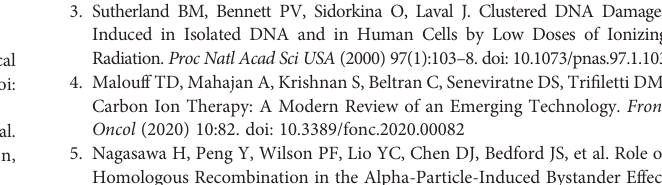
Supplementary Figure 1 | Sham-irradiated plating ef fi ciencies (PE) ± SEM for G0/G1-phase normal NFF28 primary fi broblasts (A) and asynchronously growing A549 lung carcinoma (B) , U2OS osteosarcoma (C) , and U87MG malignant glioma cells (D) pretreated for 18 h with 0.1% DMSO (vehicle control) or 1 – 20 µM concentrations of SAHA, M344, and PTACH. Asterisks mark signi fi cant differences at p -values of ≤ 0.05 (*), ≤ 0.01 (**), ≤ 0.001 (***), and ≤ 10 − 4 (****). Supplementary Figure 2 | Clonogenic survival of G0/G1-phase normal NFF28 primary fi broblasts (A) and asynchronously growing A549 lung carcinoma (B) , U2OS osteosarcoma (C) , and U87MG malignant glioma cells (D) pretreated for 18 h with 1 – 20 µM concentrations of M344 and exposed to 0.5 – 6 Gy cesium-137 g -rays. Data reported as mean ± SD; where error bars are not visible, they are smaller than the data point. Asterisks mark signi fi cant differences at p -values of ≤ 0.05 (*). Supplementary Figure 3 | Clonogenic survival of G0/G1-phase normal NFF28 primary fi broblasts (A) and asynchronously growing A549 lung carcinoma (B) , U2OS osteosarcoma (C), and U87MG malignant glioma cells (D) pretreated for 18 h with1 – 20 µM concentrations of PTACHand exposed to 0.5 – 6 Gy cesium-137 g -rays. Data reported as mean ± SD; where error bars are not visible, they are smaller than the data point. Asterisks mark signi fi cant differences at p -values of ≤ 0.05 (*). Supplementary Figure 4 | HDACi sensitizer enhancement ratio (SER) values ± SEM for G0/G1-phase normal NFF28 primary fi broblasts (A) and asynchronously growingA549lungcarcinoma (B) ,U2OSosteosarcoma (C) ,andU87MGmalignant glioma cells (D) pretreated for 18 h with 1 – 20 µM concentrations of SAHA,